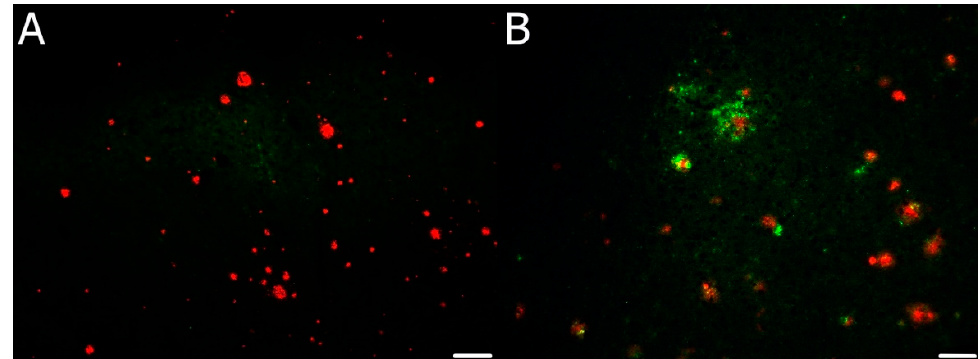
Figure 4. ( A , B ) Immunofluorescence illustration of the predominance of non-compound or mini- mal-compound plaques with minimal colocalization of A β (red) and PrP Sc (green) in the majority of plaques. Primary antibodies: anti-PrP (rabbit recombinant monoclonal antibody) + anti-amyloid β -protein (mouse monoclonal antibody). The secondary antibody was conjugated with either Alexa Fluor ® 488 (anti-rabbit IgG; green) or Alexa Fluor ® 568 (anti-mouse IgG; red). Scale bars indicate 100 μ m. Images come from the hippocampal region (archicortical parts).